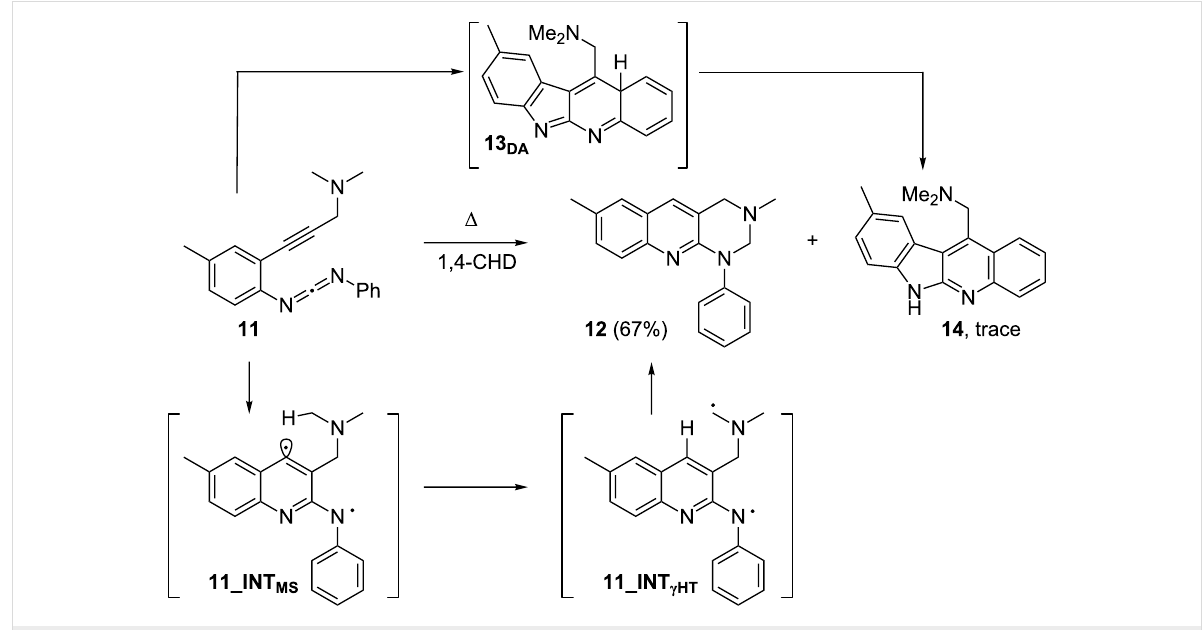
Scheme 5: Thermolysis of enyne-carbodiimide 11